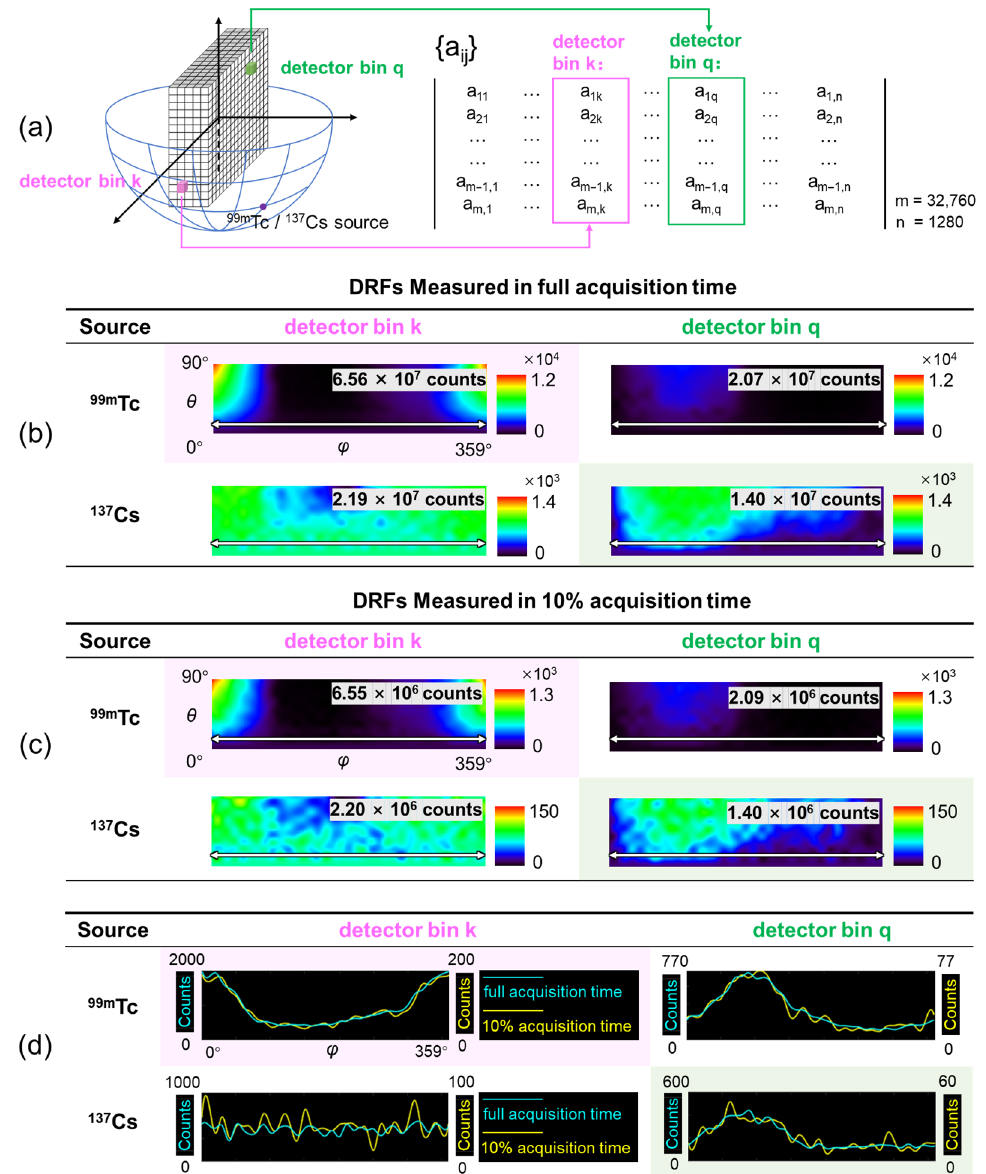
Figure 4. ( a ) Illustration of the geometrical relationship between calibration measurement (left) and the measured SM (right). ( b ) DRF images of two representative detector bins for 99m Tc and 137 Cs sources (measured with the full acquisition time). ( c ) DRF images of two representative detector bins for 99m Tc and 137 Cs sources (measured with a 10% acquisition time). ( d ) Line profiles of DRF images measured with the full acquisition time (with scale marked on the left) and 10% acquisition time (with scale marked on the right).